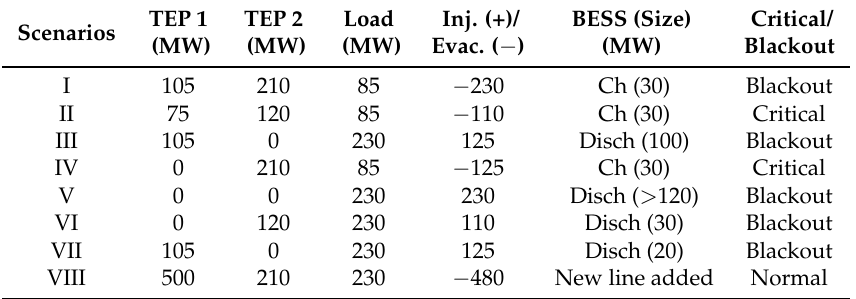
Table 8. Scenarios generated using PSS R (cid:13) E